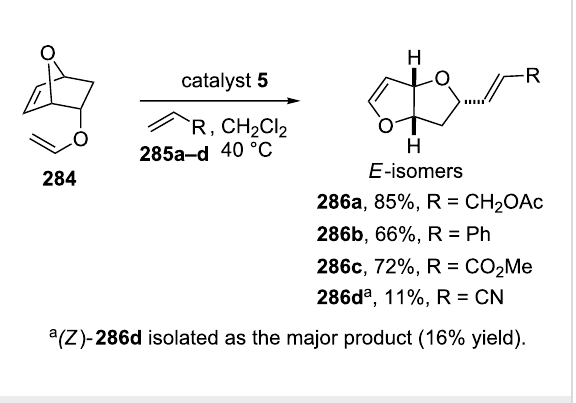
Scheme 60: RRM protocol to functionalized bicyclic